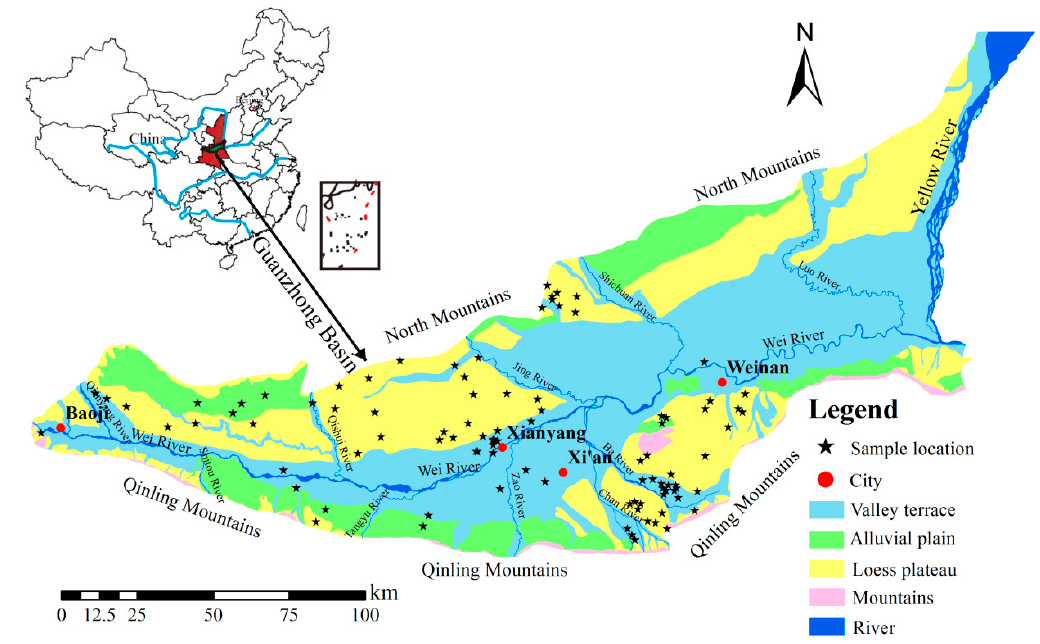
Figure 1. Study area and sampling locations.